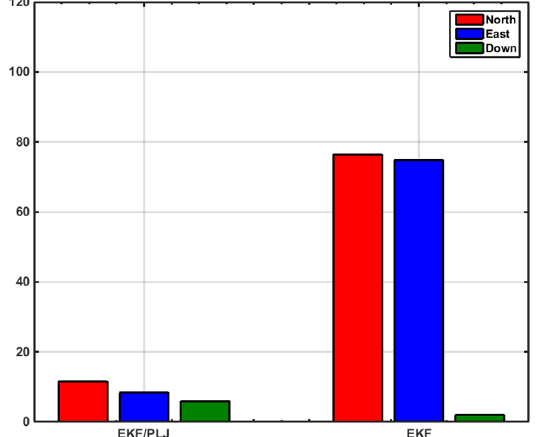
Figure 17. Maximum Position Errors—Scenario #2.